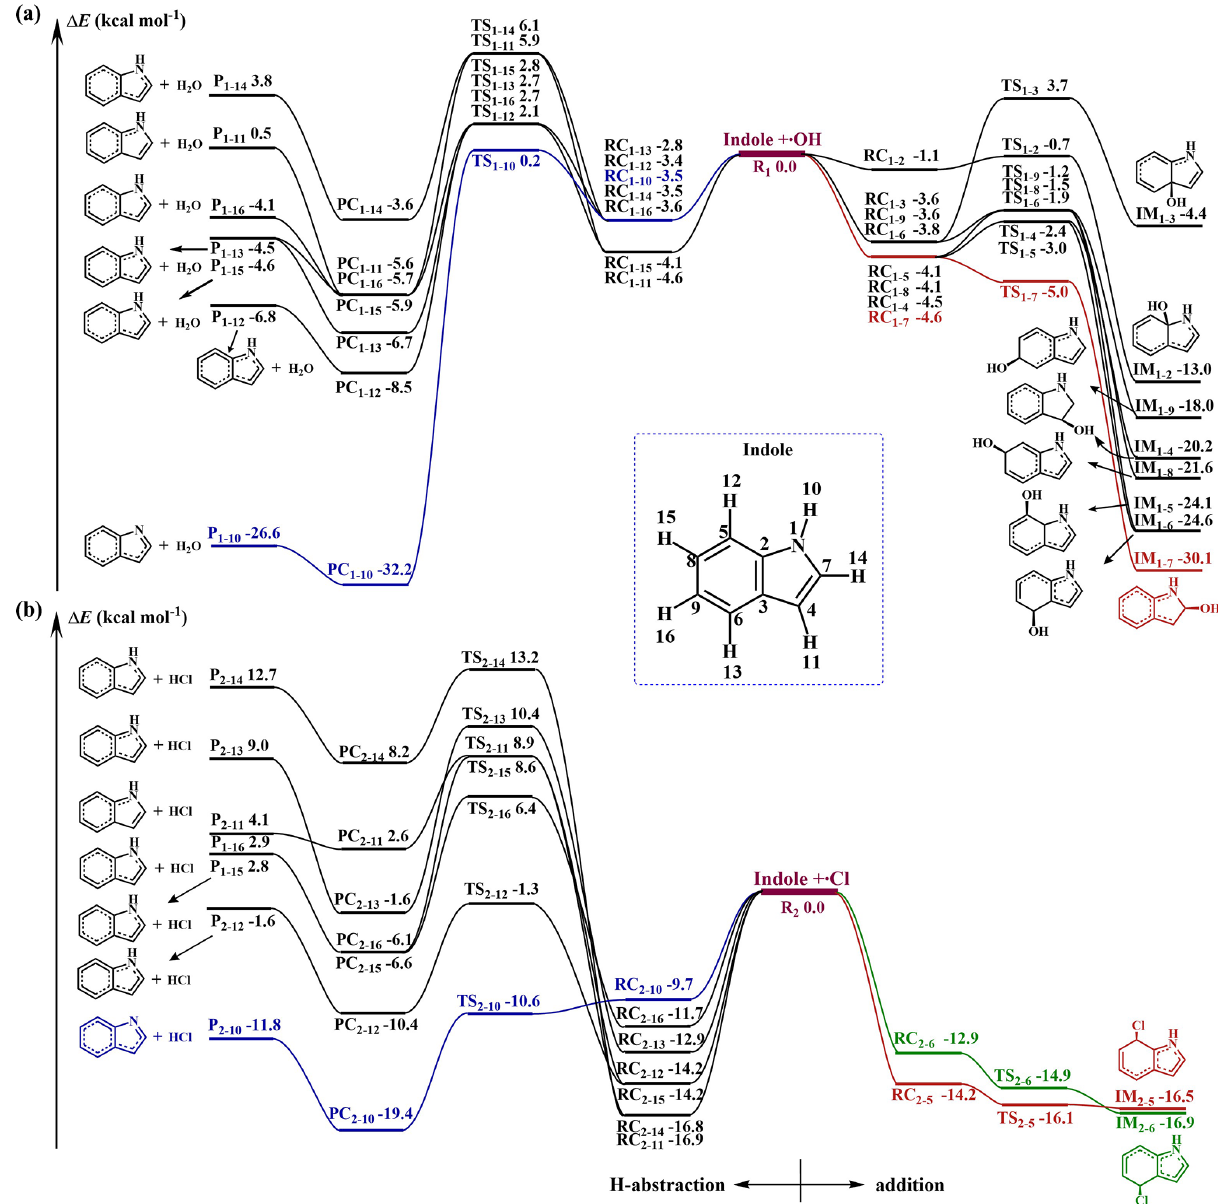
(cid:113) (cid:113) OH (a) and indole + Cl (b) at the CBS- (cid:113) (cid:113) OH and indole + Cl are set to zero, respectively